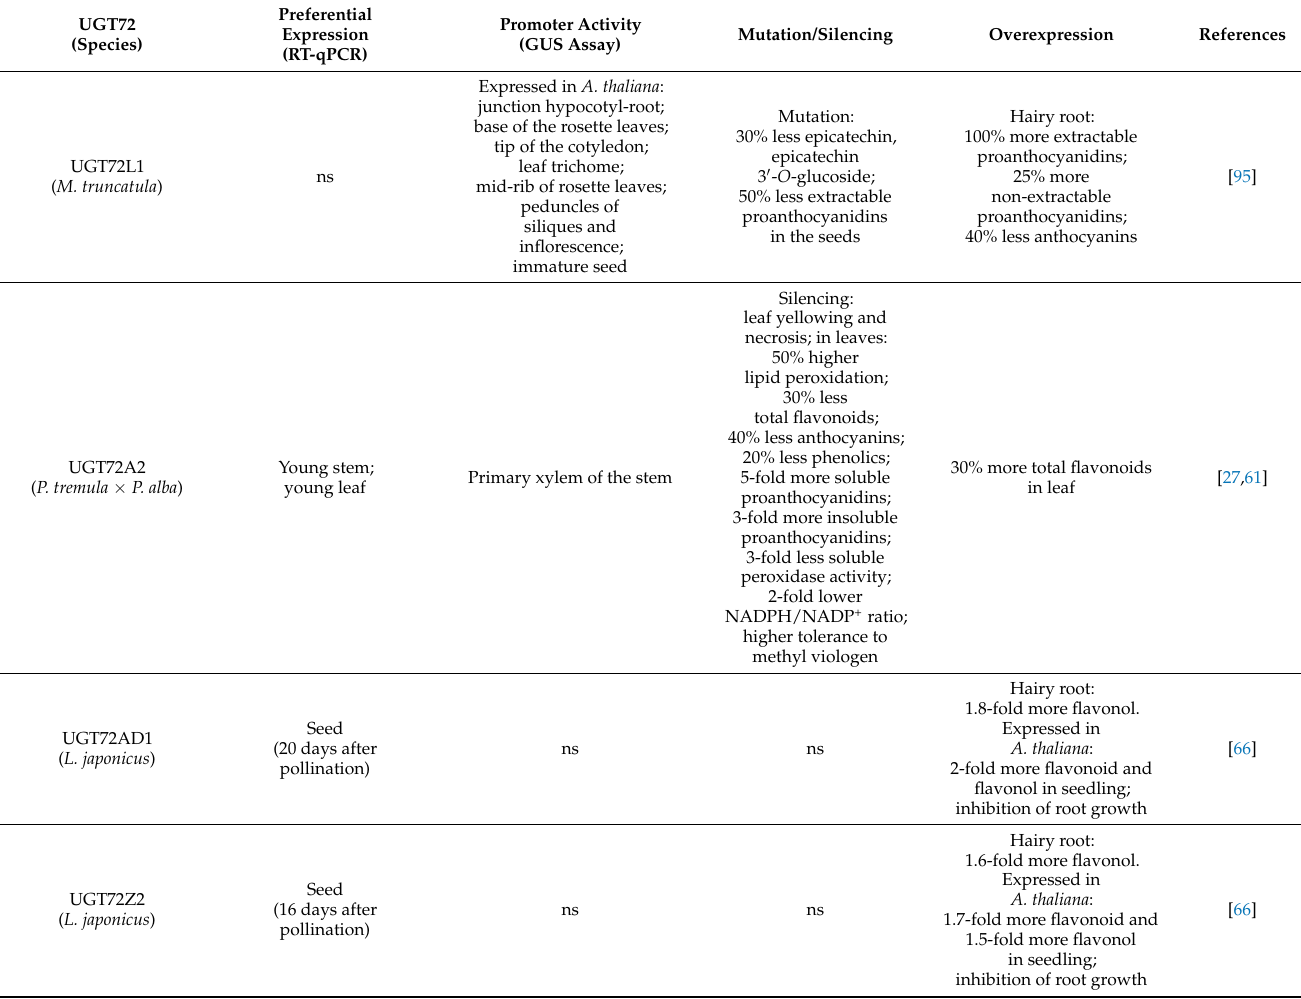
Table 4. Gene expression profile and functional characterization of UGT72 s associated with flavonoid homeostasis. ns: not studied./: no phenotype